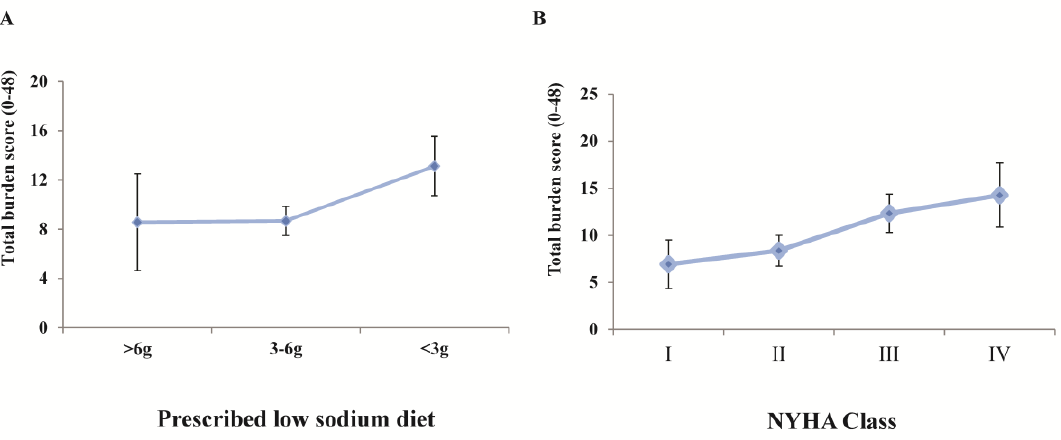
Figure 2. Global 12-item BIRD score according to ( A ) prescribed low-sodium diet and ( B ) NYHA class. Error margins indicate standard error of the mean (SEM). NYHA: New York Heart Association. Table 3. Results for convergent validity: Spearman correlation coefficients between the global burden score and the Minnesota Living with Heart Failure questionnaire domains.